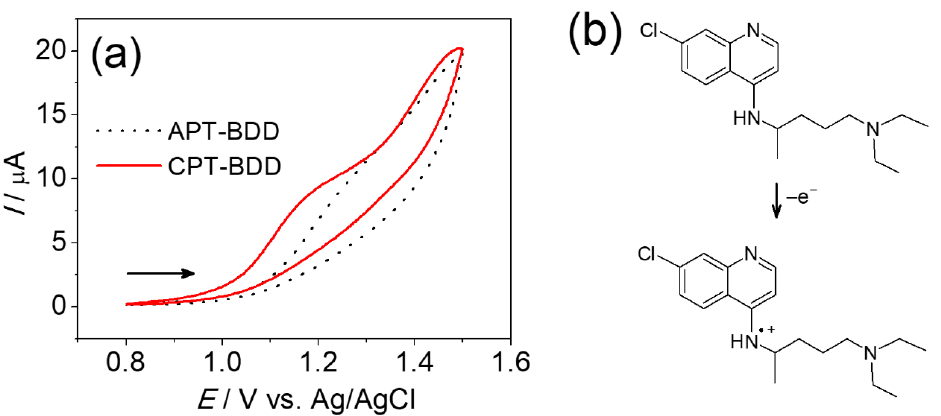
Figure 5. ( a ) Cyclic voltammograms ( v = 50 mV s −1 ) obtained for 1.5 × 10 −4 mol L −1 chloroquine solution